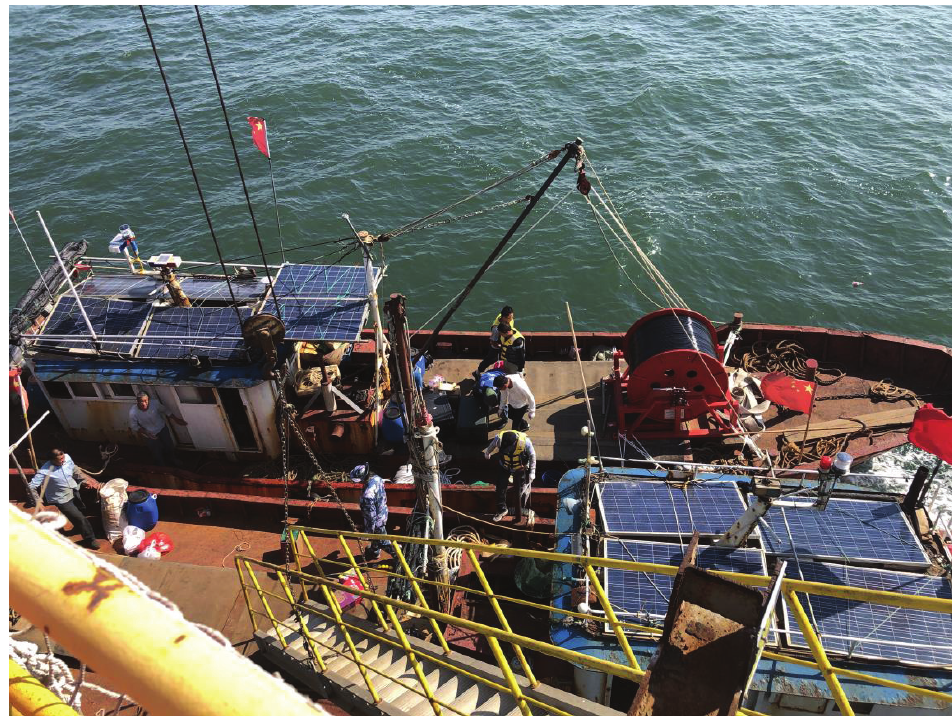
Figure 8. The layout process of sea